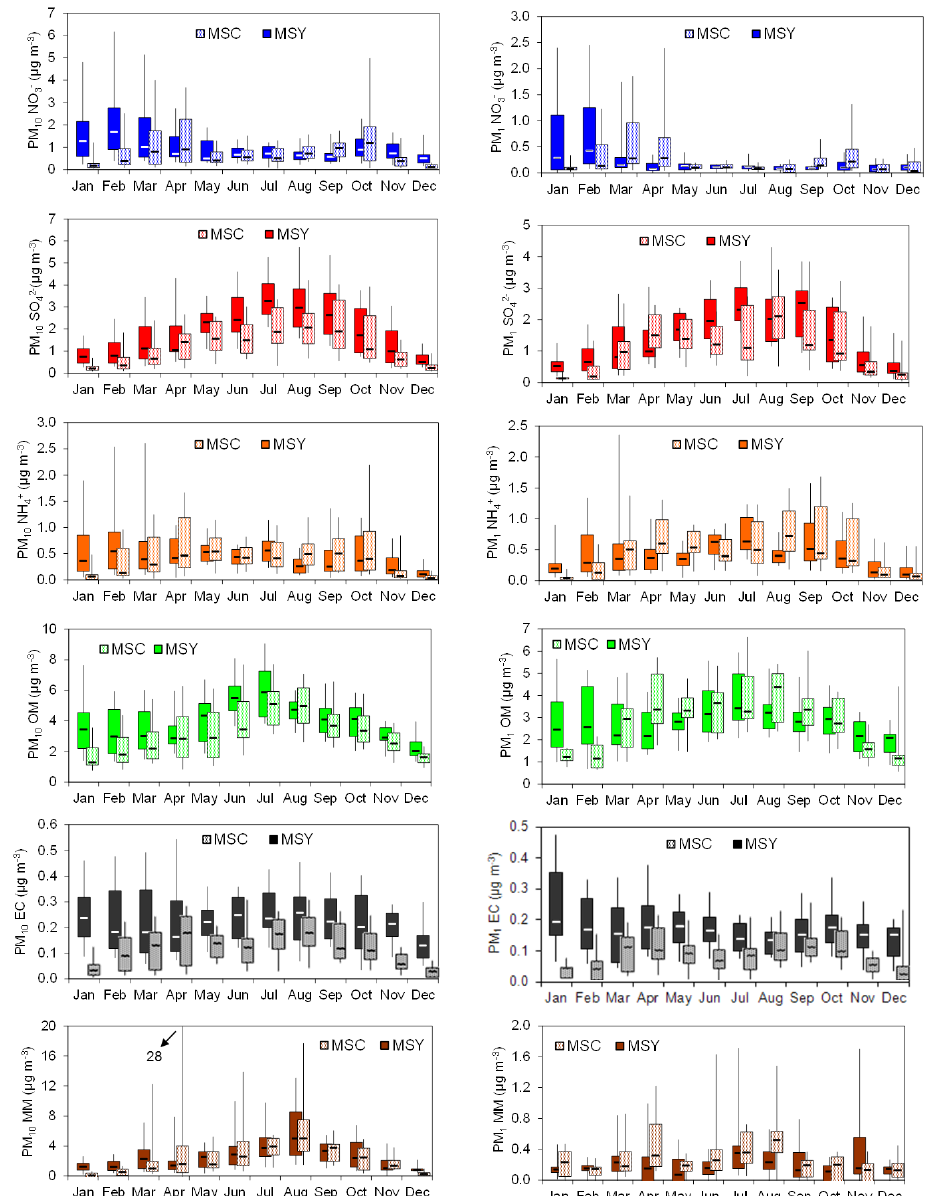
Figure 6. Monthly median (black line within the boxes) and percentiles (5–25–75–95, boxes and whiskers) of major PM 10 and PM 1 chemical components concentrations at Montsec (MSC) and Montseny (MSY) based on daily measurements between January 2010 and March